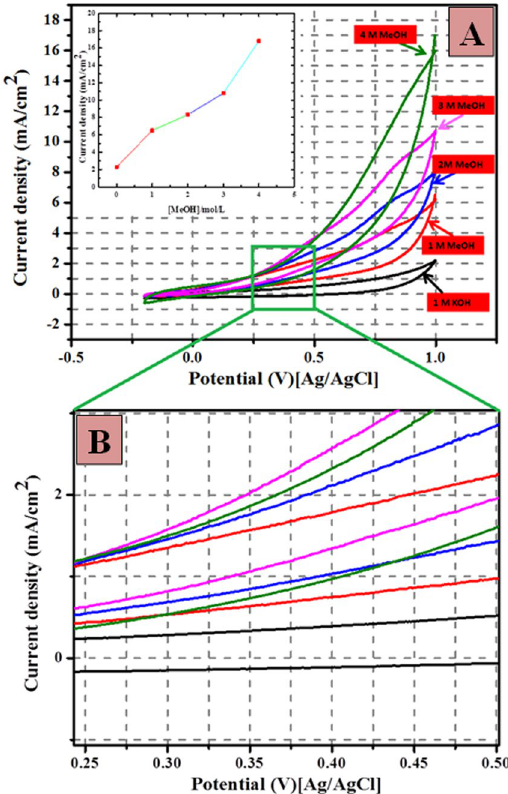
Figure 7. Typical cyclic voltammogram for the obtained core@shell (ZnO@C) carbon spheres in 1 M KOH solution in the presence of different concentration of methanol; inset image: dependency of the current density on the concentration of methanol in solution and high megnification ( B ) to show the onset potential at the scan rate 50 mV/s at 25